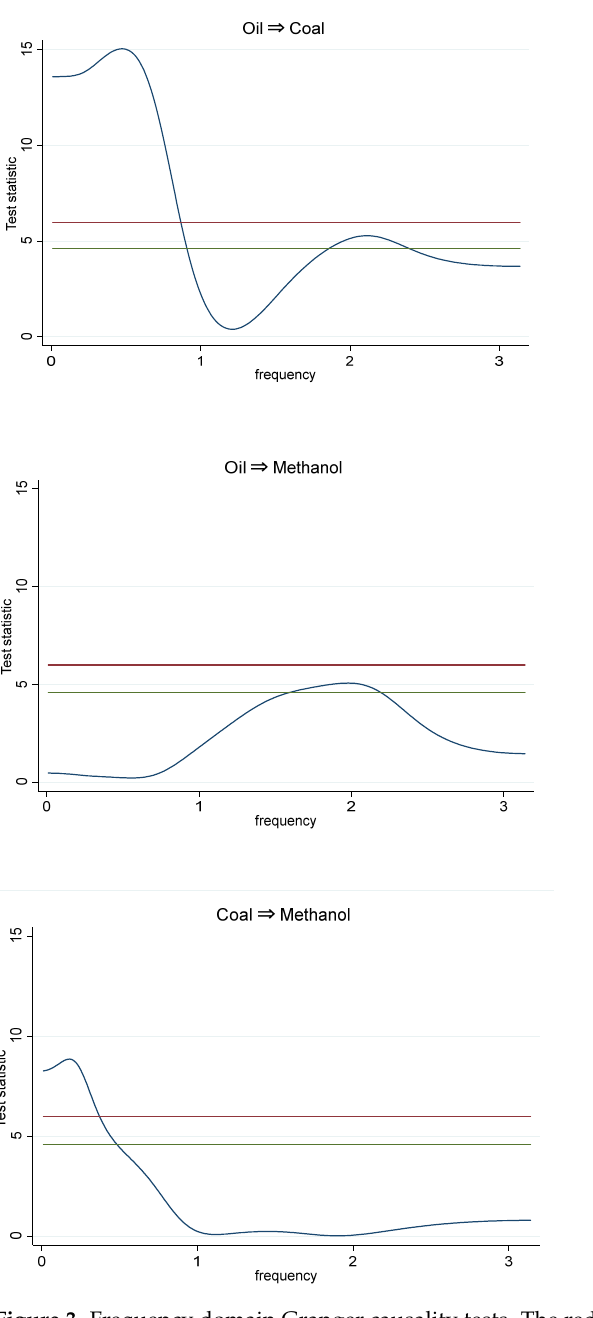
Figure 3. Frequency domain Granger causality tests. The red and green horizontal lines represent the 5% and 10% critical values, respectively. When the blue line sits above the critical values, we may conclude the existence of causality at the frequency level identified along the x -axis.